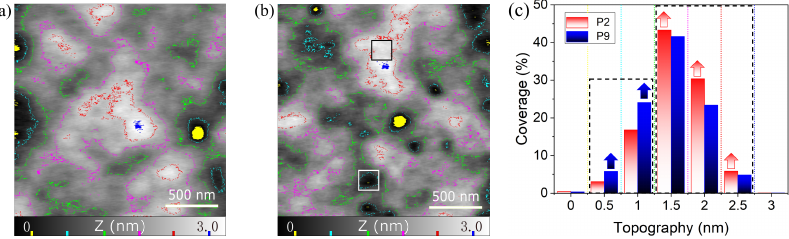
Figure 5. AFM images in contact mode of two different areas (2 × 2µm 2 ) on sample 5% H: ( a ) P2, low µ and high S ( F N = 10 nN ) . ( b ) P9, high µ and low S ( F N = 10 nN ) . The areas of 200 × 200nm 2 highlighted by a white mark ( µ = 0.100, S = 0.12 nm ) and a black mark ( µ = 0.071, S = 0.14 nm ) show different local friction coefficients, respectively. ( c ) The coverage distribution at different regions (equally divided by the colorful dotted lines) for P2 and